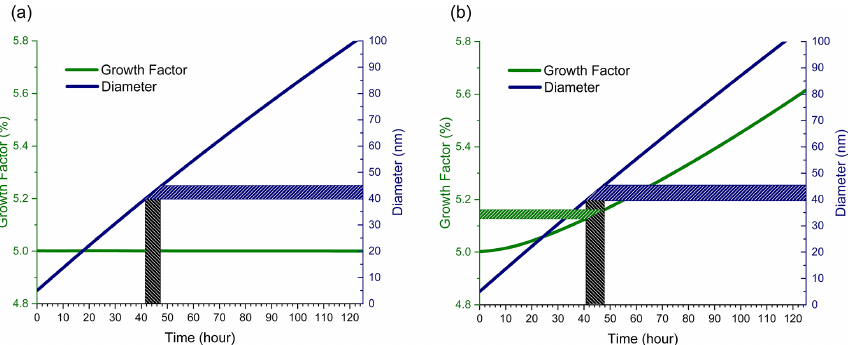
Figure 1. Growth factor and diameter vs. time for dry (no ALW) ammonium sulfate seed particles with an initial diameter of 5nm. (a) Con- densation of NVOCs and partitioning of SVOCs only. (b) SVOC 0 dimer formation in addition to condensation and